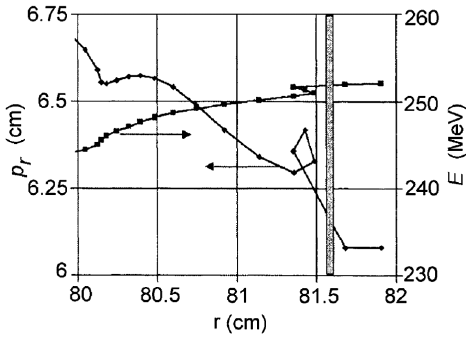
FIG. 8. Radial momentum component p r and energy as a function of radius near extraction. The data points represent all the turns at extraction and the bar at 81.6 cm represents the extraction septum